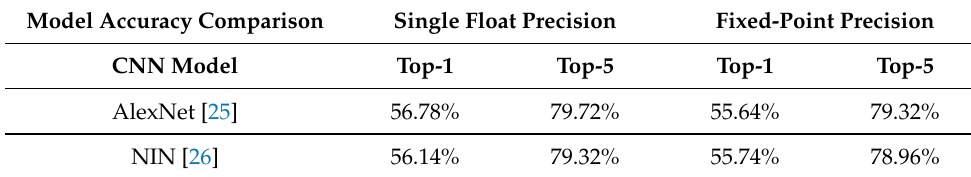
Table 2. Accuracy comparison with the ImageNet dataset, adapted from